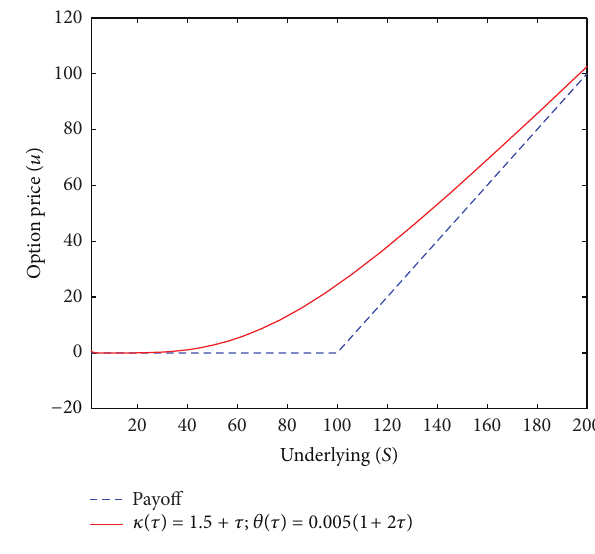
Figure 6: A time-dependent